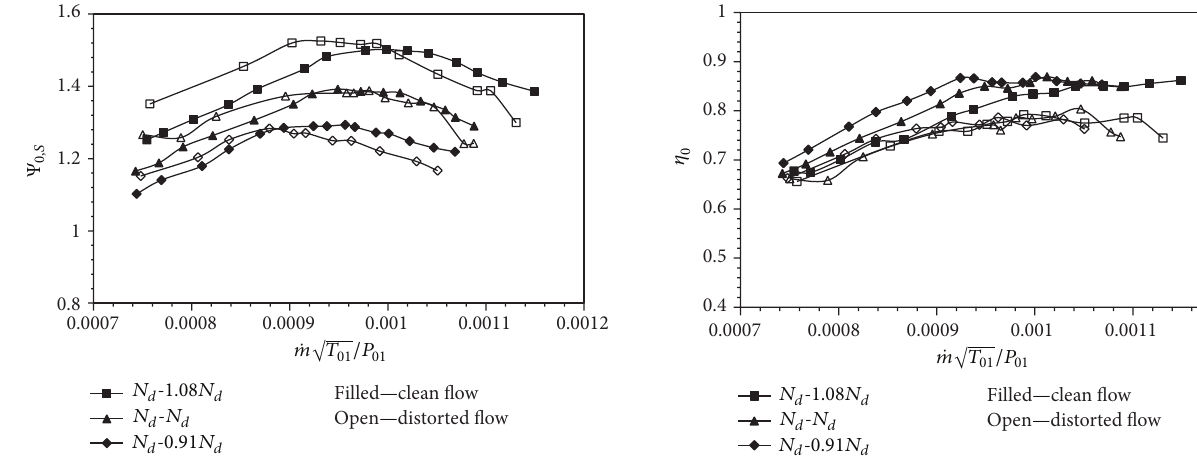
Figure 10: Performance characteristic under clean and tip-strong radial inflow distortion.